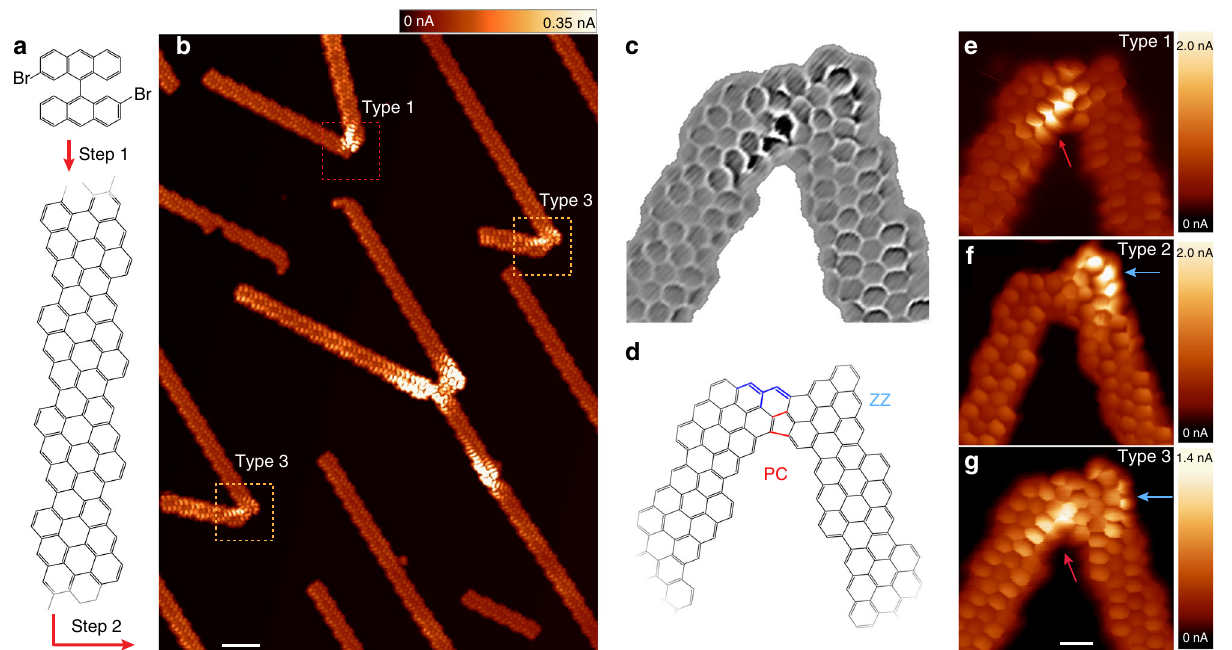
Fig. 1 Formation of GNR junctions. a Model structures of the organic precusor 2,2 ′ -dibromo-9,9 ′ -bianthracene and of the on-surface synthesized (3,1) chGNR after Ullmann-like C – C coupling reaction and cyclodehydrogenation on Au(111). b Constant-height current images ( V = 2 mV, scale bar: 2 nm) showing joint chGNR nanostructures, with an angle of ~50°, obtained after further annealing the sample. A CO-functionalized tip was used to resolve the chGNR ring structure. Dashed boxes indicate the most characteristic chGNR junctions, whose structure is shown in panels c , d . c Laplace- fi ltered image of the junction shown in panel g to enhance the backbone structure, and ( d ) model structure of the junction. PC labels the pentagonal cove site and the ZZ the zigzag site. e – g Constant-height current images ( V = 8 mV, scale bar 0.5 nm) of the three types of chGNR junctions with same backbone structures but with different LDOS